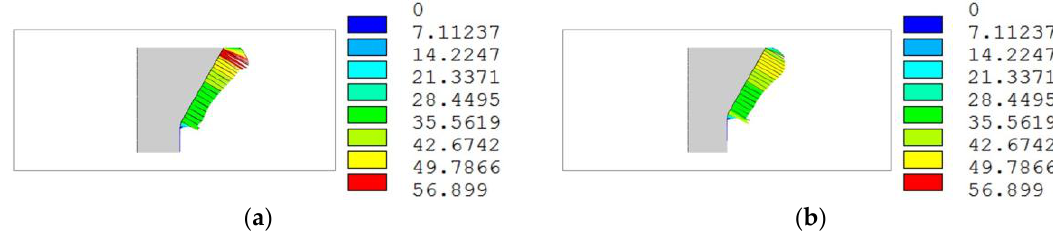
Figure 8. Contact pressure distribution of ( a ) displacement load and ( b ) pressure load.